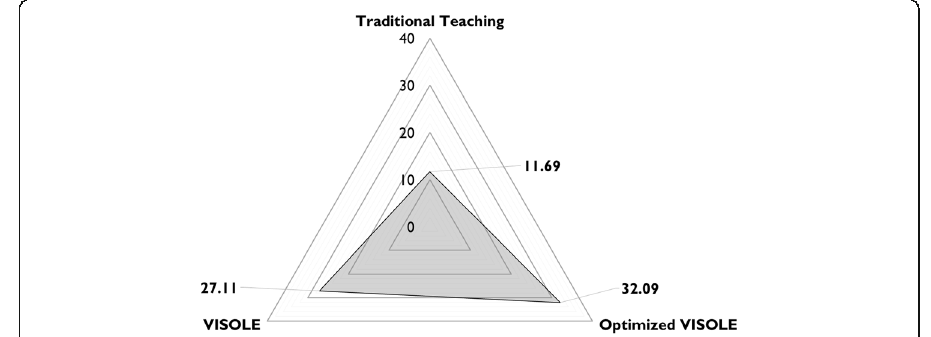
Fig. 4 Overall comparison on knowledge test mean scores obtained at School